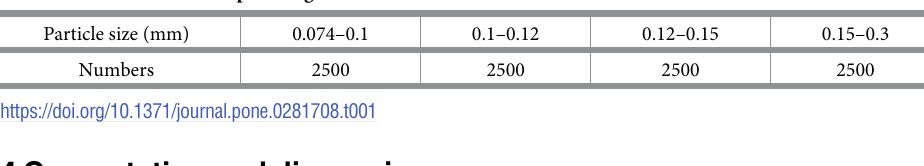
Table 1. The first simulated particle gradation.